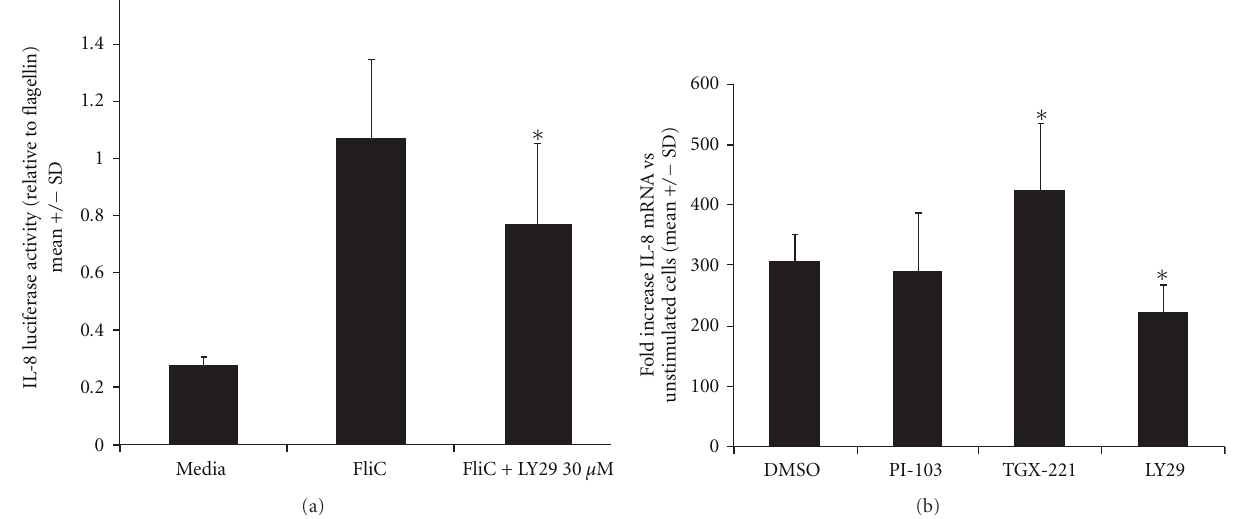
Figure 3: PI3K inhibition reduces flagellin-stimulated IL-8 promoter activation and mRNA production. (a) Caco-2 cells were electroporated with and IL-8 promoter/luciferase reporter plasmid and pEGFP as a transfection marker and grown as described in Methods. Cells were pretreated with inhibitors at the concentrations shown (or an equivalent volume of DMSO vehicle) followed 30 minutes later by flagellin 100ng/ml. After 6 hours, cells were harvested for luciferase assay and fluorescence determination. The RLU/RFU value was calculated for each well, and these data normalized to the wells stimulated with DMSO + flagellin in each individual experiment. Data shown are compiled from at least 3 experiments for each inhibitor. ∗ P < . 01 ( t -test). (b) IL-8 mRNA measurements by quantitative RT-PCR compiled from at least 3 experiments. Cytoplasmic RNA isolated from cells treated as shown was reverse transcribed. cDNA was amplified using actin and IL-8 primers with real-time fluorescent quantitation. Fold increases in mRNA were calculated as described in Methods. Results are expressed as the ratio compared to cells treated with flagellin plus DMSO vehicle. ∗∗ P < . 05 versus flagellin plus DMSO ( t -test).